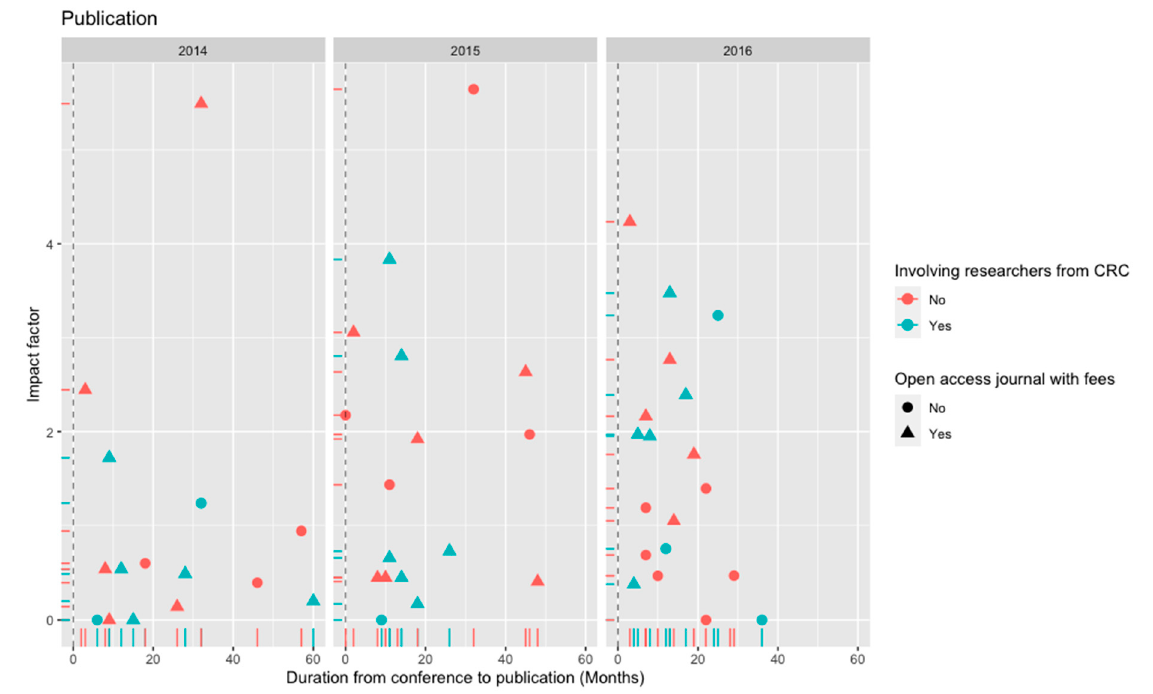
Figure 1. Scatter plot displaying the relationship of journal impact factor against the duration from conference to publication (Months) for the published abstracts that were presented at the 2014, 2015, and 2016 NCCR.